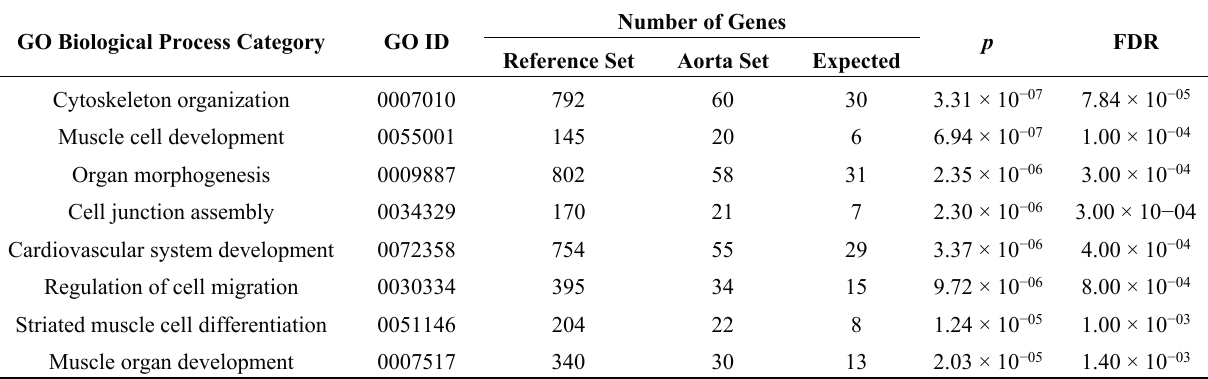
Table 8. Enriched GO biological process categories for the down-regulated target genes identified in AAA ChIP-chip with transcription factors RUNX1, ELF1, ETS2 and STAT5.